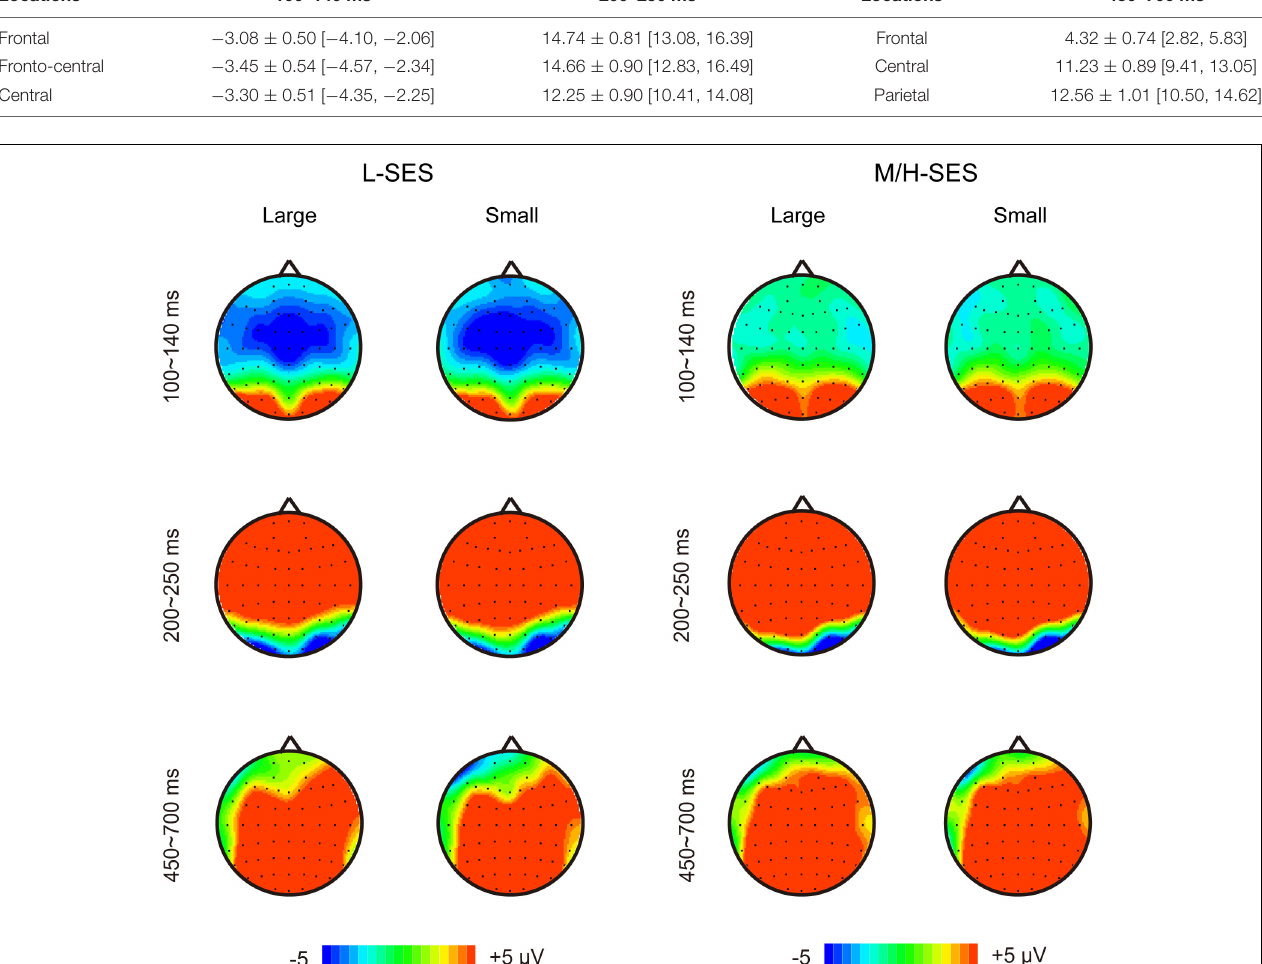
TABLE 3 | The average amplitudes of different locations in each time window during the numerical comparison ( µ V) ( M ± SD [95% CI ]). Locations